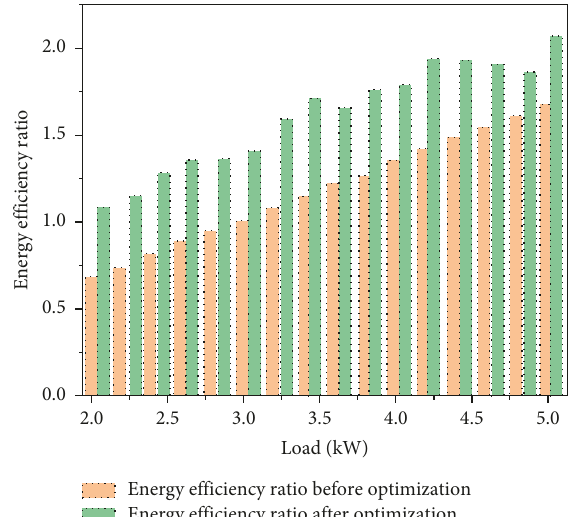
Figure 16: Comparison of energy efficiency before and after ge- netic algorithm